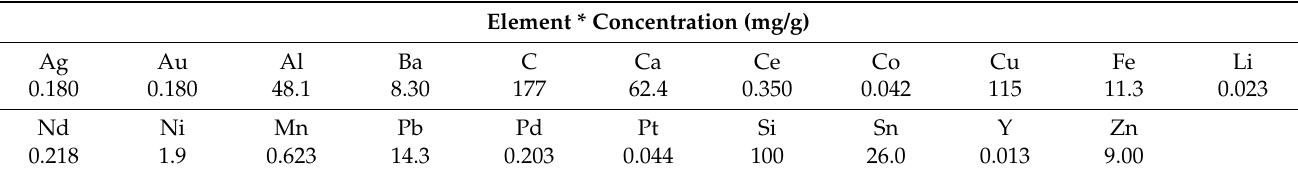
Table 1. Element distribution of fine PPCB